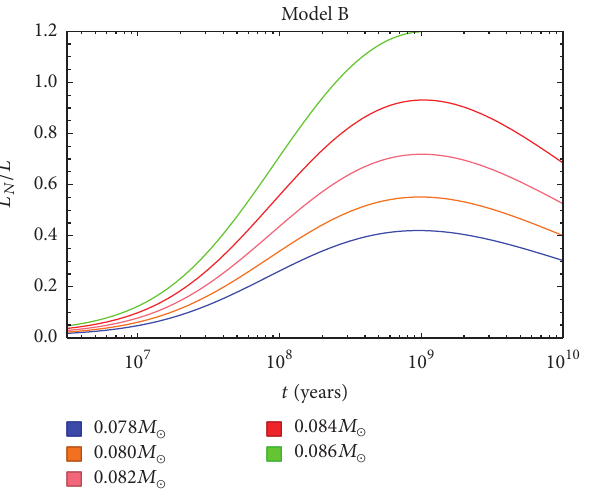
Figure 3: The variation of 𝐿 𝑁 /𝐿 over time 𝑡 for different masses for model B in Table 1.